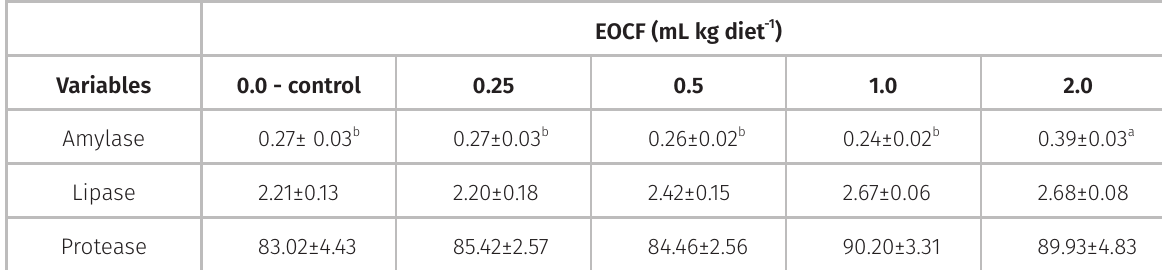
Table III. Activity of intestinal enzymes (UI mg protein -1 ) of Nile tilapia fed with diets containing different concentrations of the essential oil of Cymbopongon flexuosus